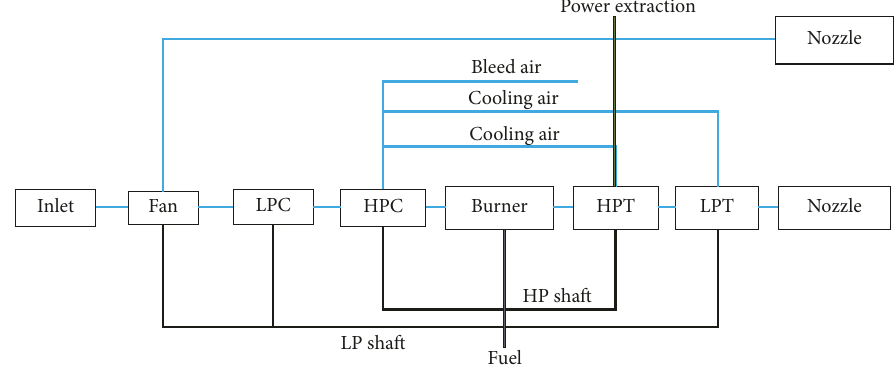
Figure 2: Turbofan engine model with two-spool separate exhaust.